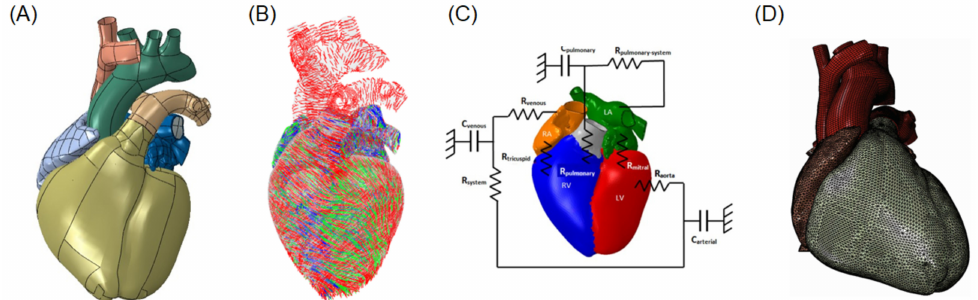
Figure 2. Sketch of LHHM implementation: ( A ) heart and great vessel geometries; ( B ) fiber architec- ture; ( C ) coupling with 1D lumped-parameter model; ( D ) structural